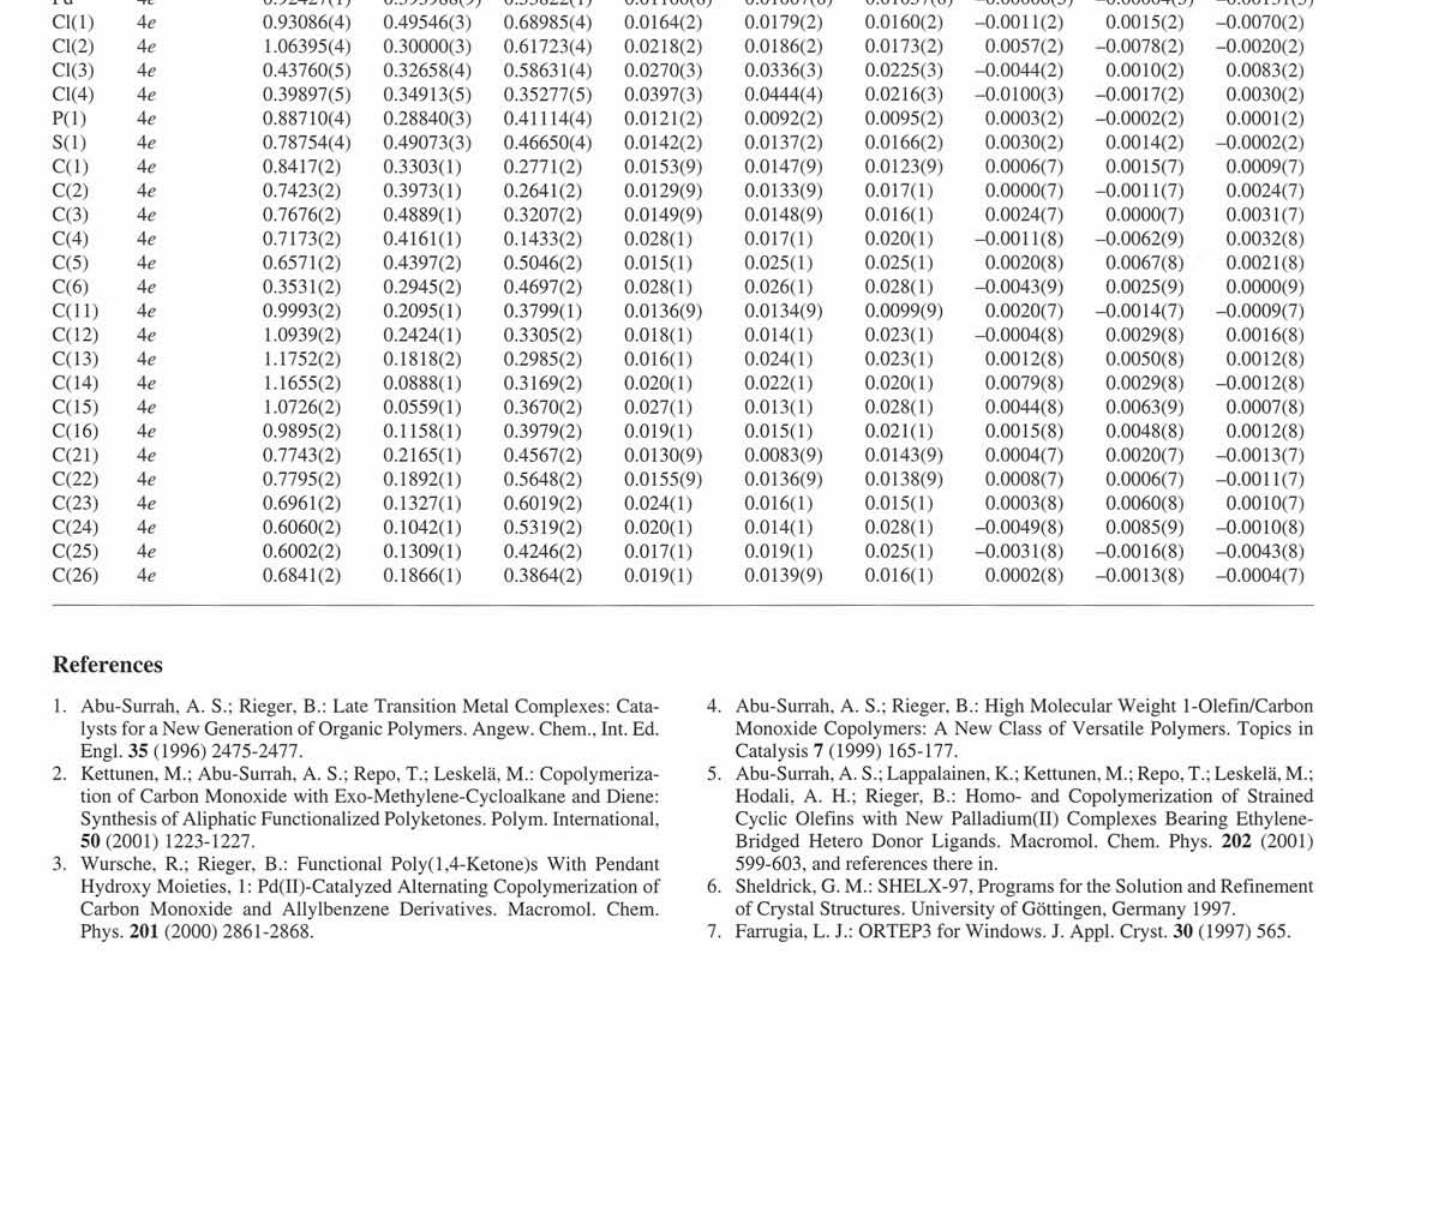
Table 3. Atomic coordinates and displacement parameters (in Á 2